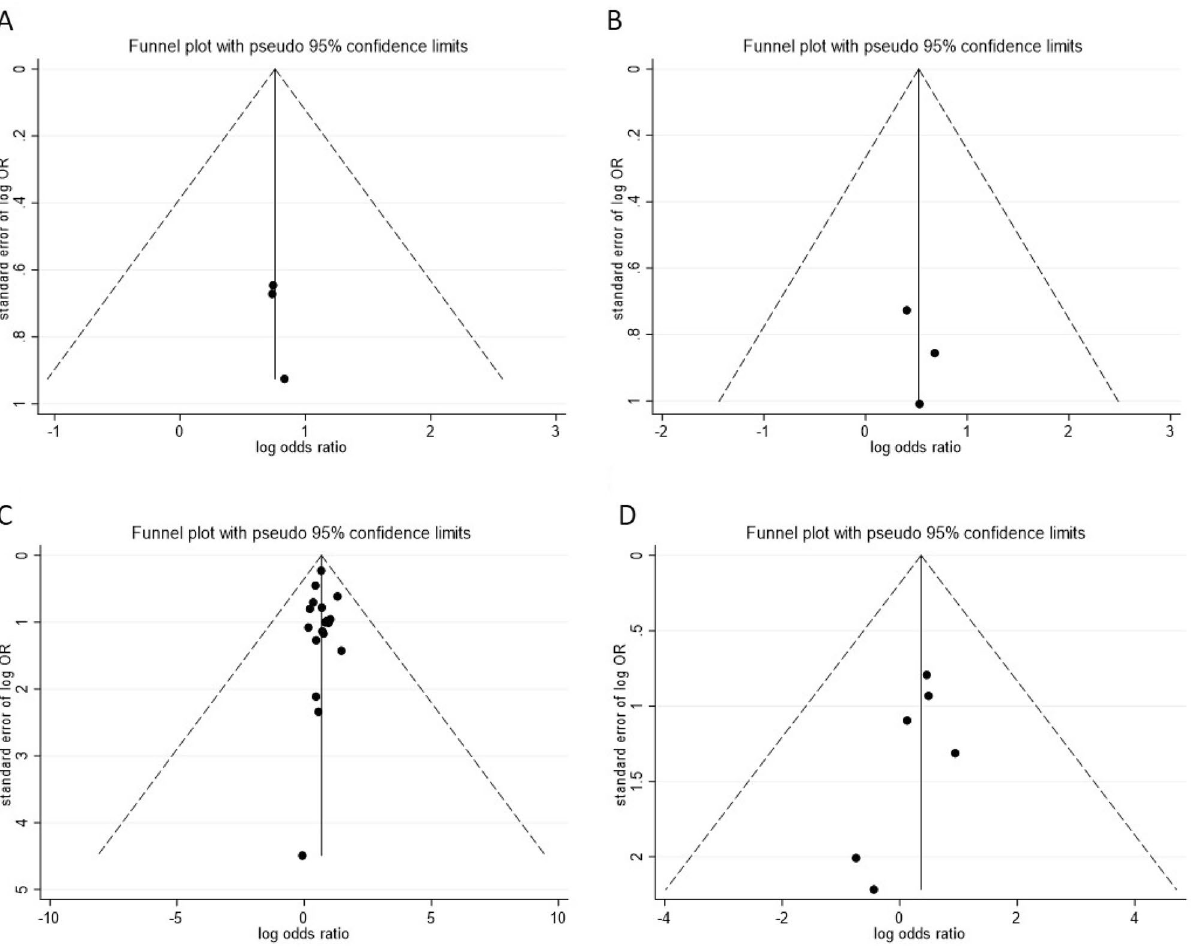
Figure 6. Funnel plots between prepregnancy obesity and micronutrient deficiency, including those of vitamin B12 ( A ), folate ( B ), vitamin D ( C ), and iron ( D